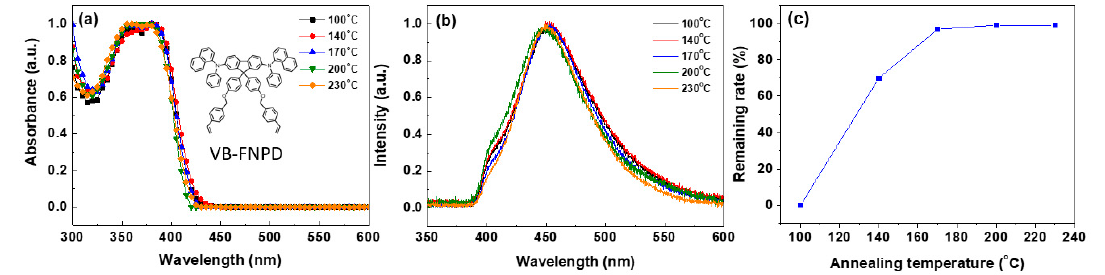
Figure 2. ( a ) Absorbance, ( b ) photoluminescence (PL), and ( c ) remaining rate of 9,9 ‐ Bis[4 ‐ [(4 ‐